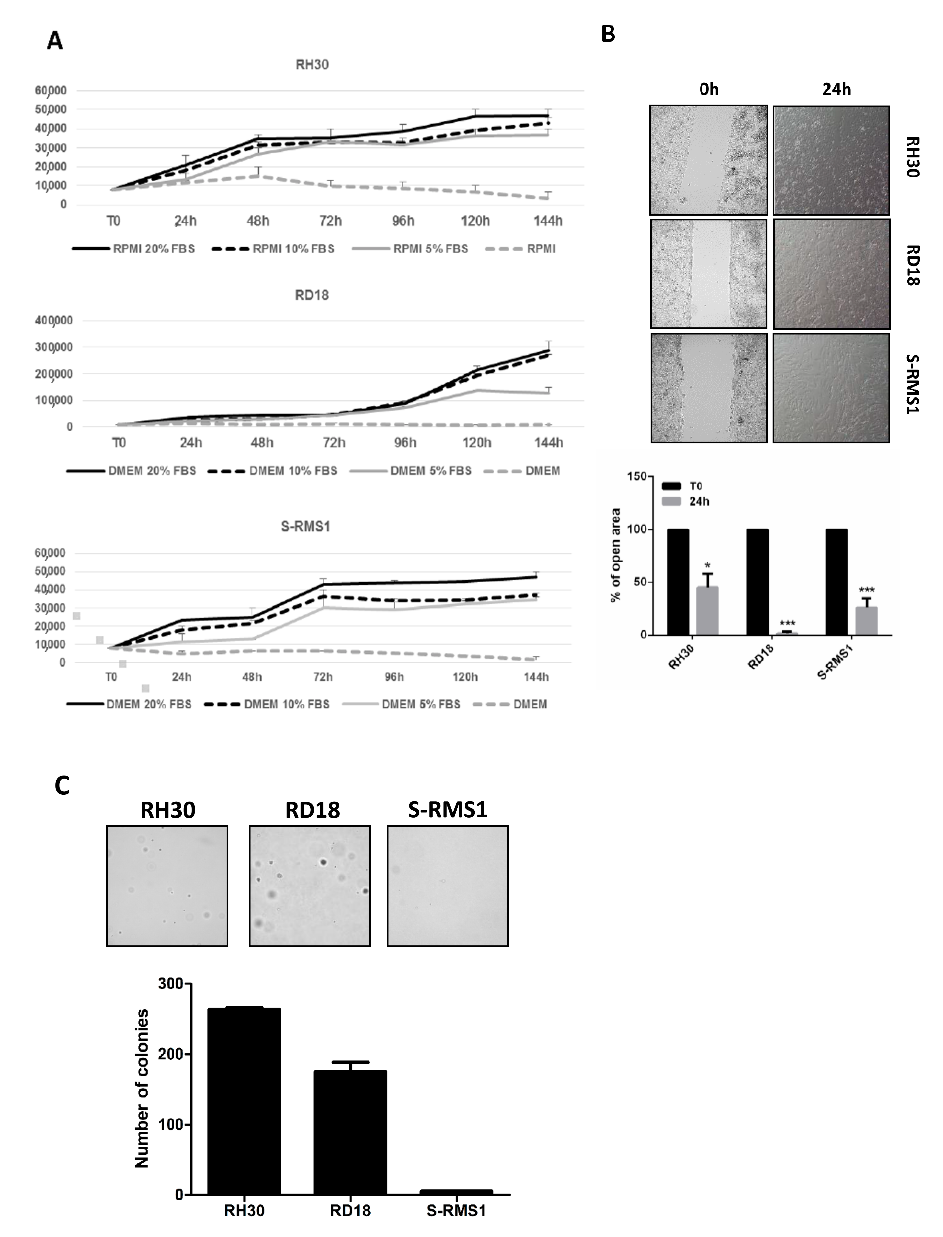
Figure 5. Tumorigenic properties of S-RMS1 cell line. ( A ) Serum independent growth of S-RMS1, RH30, and RD18 cells. ( B ) Representative phase contrast microscopy images of the migration assay at 0 and 24 h after gap creation. The histogram depicts the measurement in percentage of the total area between the wound edges of the scratch from at least five random fields per scratch from three independent experiments. Data are shown as mean ± SEM. * p < 0.05; *** p < 0.0001 Student’s t -test. ( C ) Clonogenic ability in anchorage-independent manner of S-RMS1, RH30, and RD18 cell lines. Histogram depicts the number of colonies per plate after 4 weeks of incubation, calculated as means ± SEM from three independent experiments.